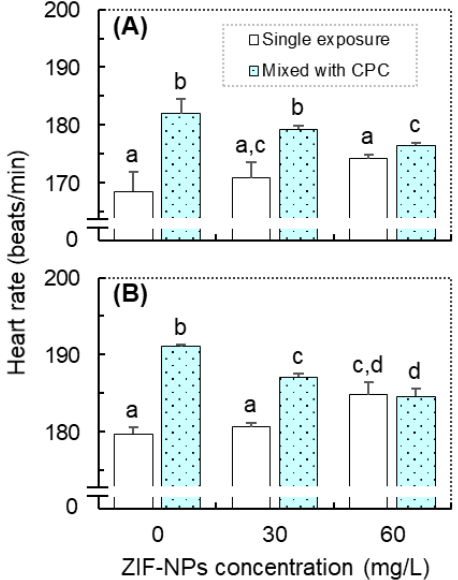
Figure 2. The heart rates of zebrafish ( Danio rerio ) in the combined exposure groups of cetylpyridinium chloride (CPC; 0 and 20 µ g/L) and ZIF-8 nanoparticle (ZIF-NPs; 0, 30, and 60 mg/L). Data are means ± SE ( n = 3), which were measured at 48 ( A ) and 72 ( B ) hours post-fertilization (hpf). Values that do not share a common letter are significantly different at p < 0.05.